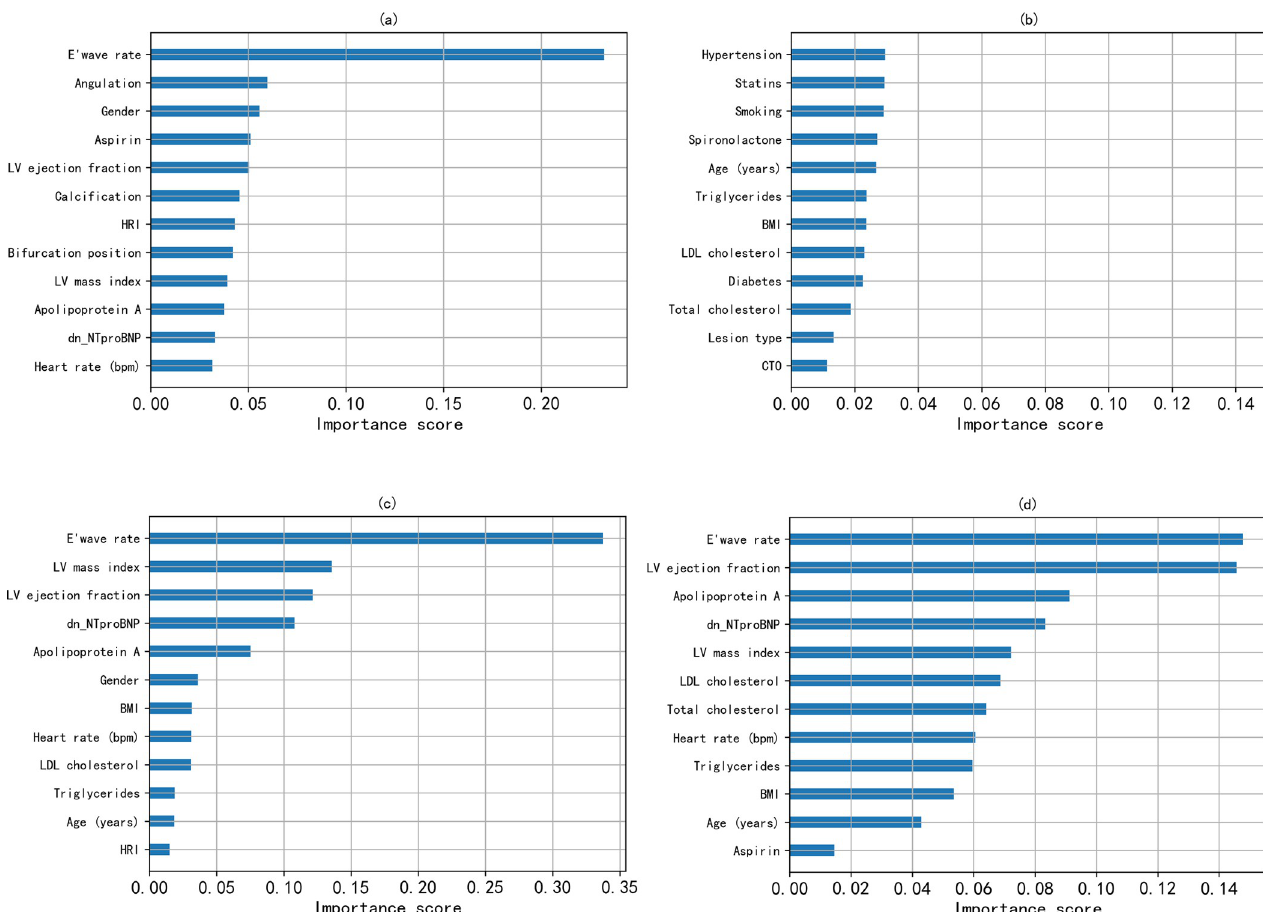
Fig 5. Feature importance scores calculated by information gain. (a) ranking of the XGBoost top 12 ACS feature contributions; (b) ranking of the XGBoost bottom 12 ACS feature contributions; (c) ranking of the GB model’s feature contributions; and (d) ranking of the RF model’s feature contributions.